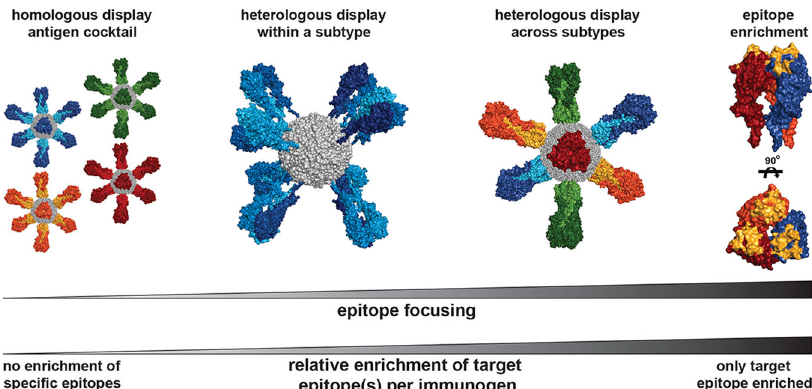
Fig. 3 Proposed use of heterologous antigen display to focus responses toward desired epitopes. A proposed spectrum of epitope focusing immunogens incorporating various multimeric or heterologous display strategies is shown; unique colors represent antigenically distinct components. As the relative overall enrichment of the target epitope increases, so does the degree of epitope focusing. Heterologous display within a subtype presents a wider gradient of conserved epitopes due to the smaller antigenic distance between presented components. Heterologous display of antigenically distinct antigens enriches for conserved epitopes, but there are still other epitopes that are conserved between various combinations of component antigens. The endpoint of this spectrum is an epitope-enriched immunogen, where a single epitope is presented as multiple copies with all other epitopes presented once. All images created in PyMol using PDBs 5UGY and